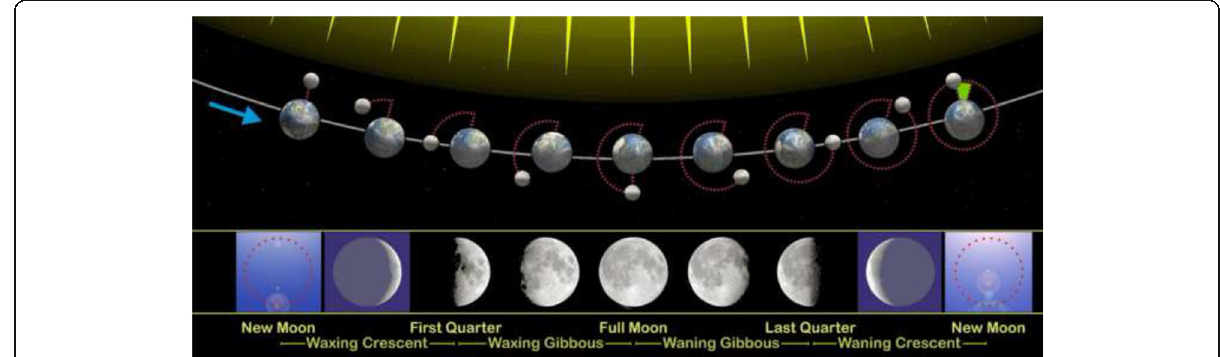
Fig. 2 Moon phases as seen looking southwards from the northern hemisphere (upper part of the diagram not to scale, as the Earth-Moon distance is much bigger than shown here; © Orion 8/Wikimedia